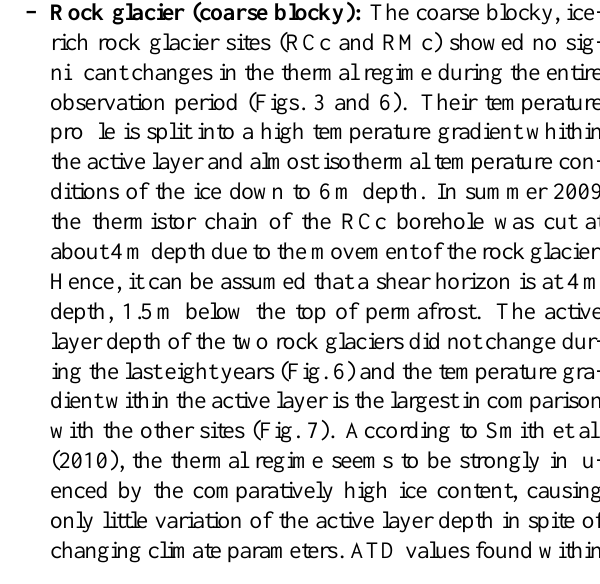
Fig. 11. Temperature transfer rate, calculated as 6 year mean from maximum summer borehole temperatures from 0.5m depth to the lower limit of the active layer in K m − 1 d − 1